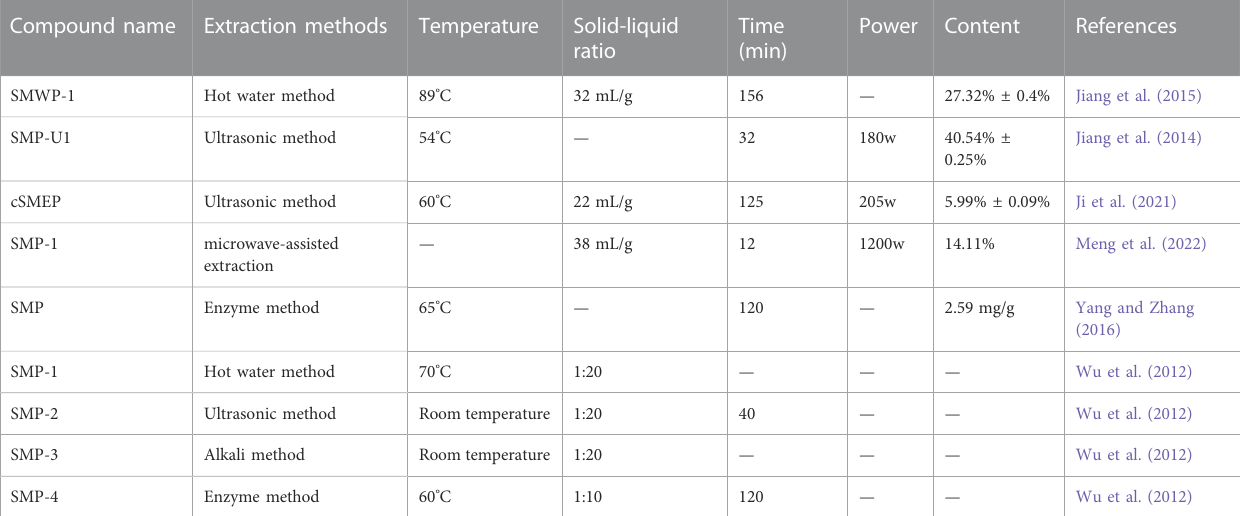
TABLE 1 A summary of the extraction methods of